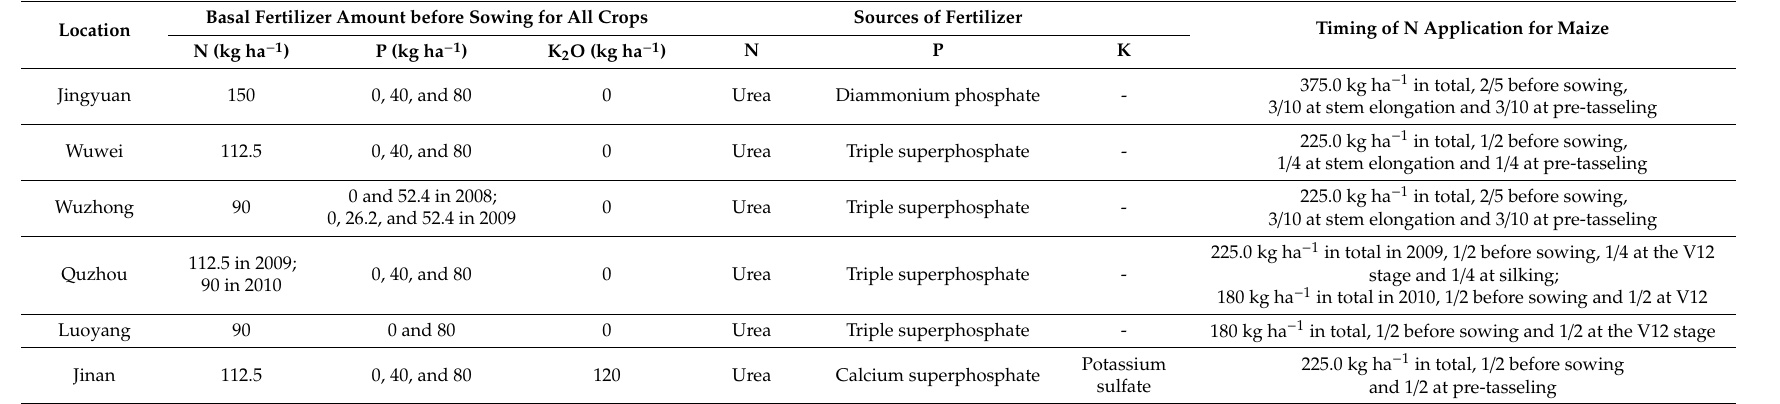
Table 6. Detailed fertilization arrangements in di ff erent experimental